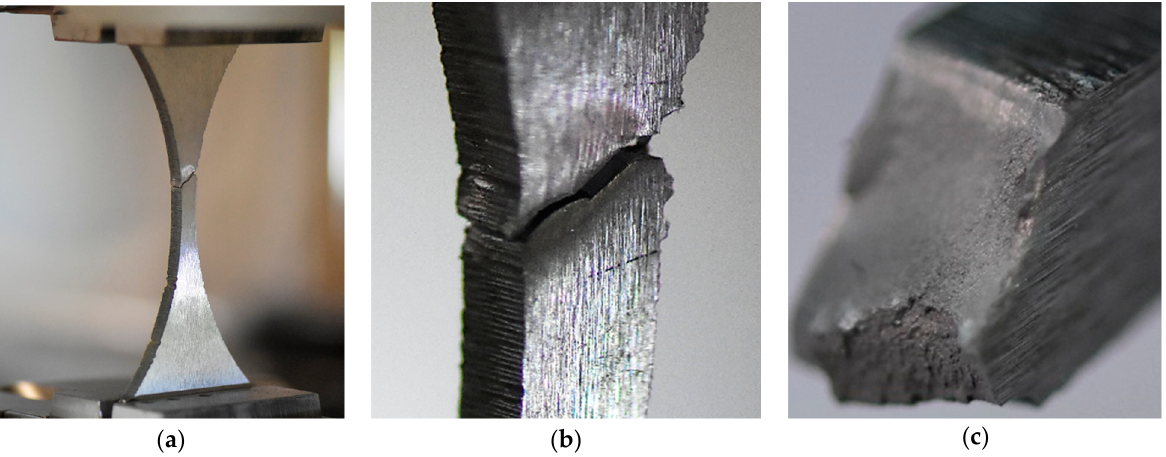
Figure 9. Hardox 450 with the MAG weld from the fatigue test under the maximum value of stress equal to 1021 MPa, ( a , b ) directly after separation, and ( c ) fracture region.